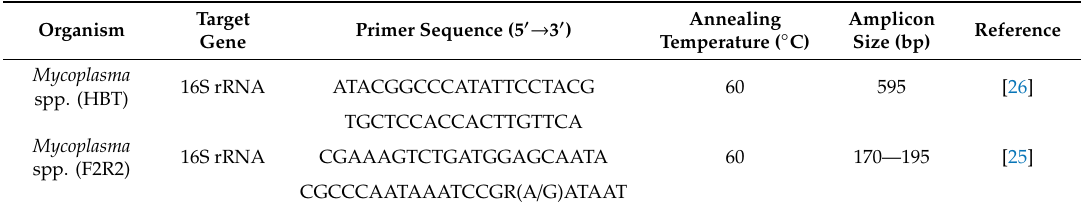
Table 1. Organisms, target genes, PCR oligonucleotide primers, amplicon size, and references for the PCR